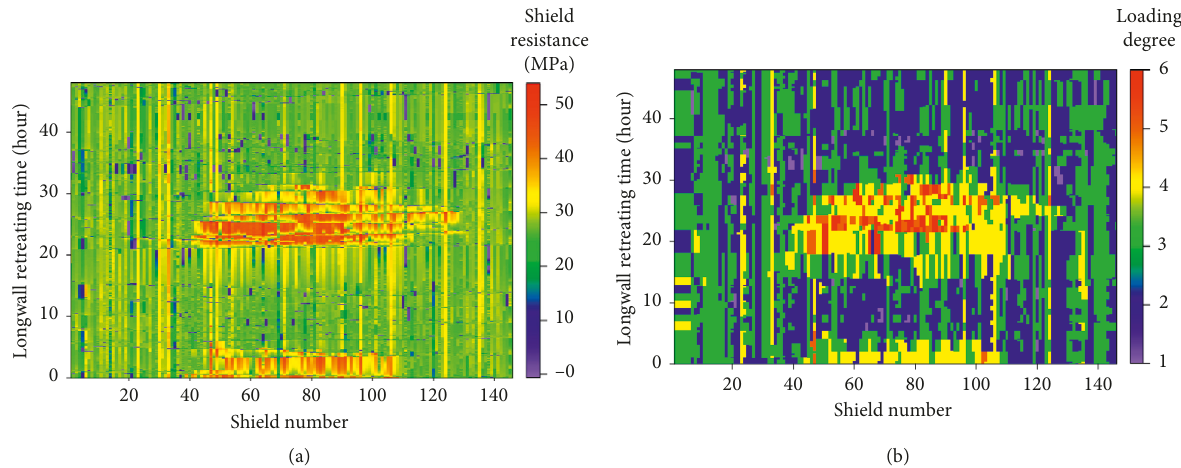
Figure 15: Evolution of shield resistance and loading degree of a shield-supporting cycle before and after a typical period of roof weighting.